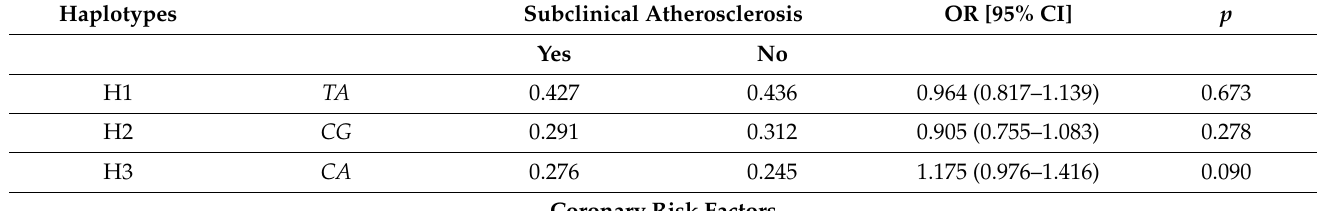
Table 4. Association of FOXA3 haplotypes with SA and with cardiovascular risk factors in SA and healthy